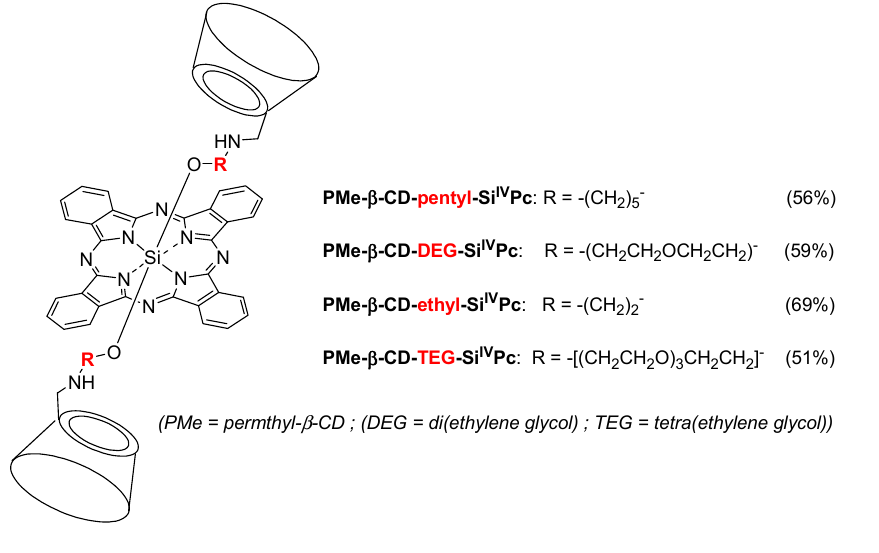
Figure 23. Chemical structure of PMe- β -CD- R -Si IV Pc conjugates.